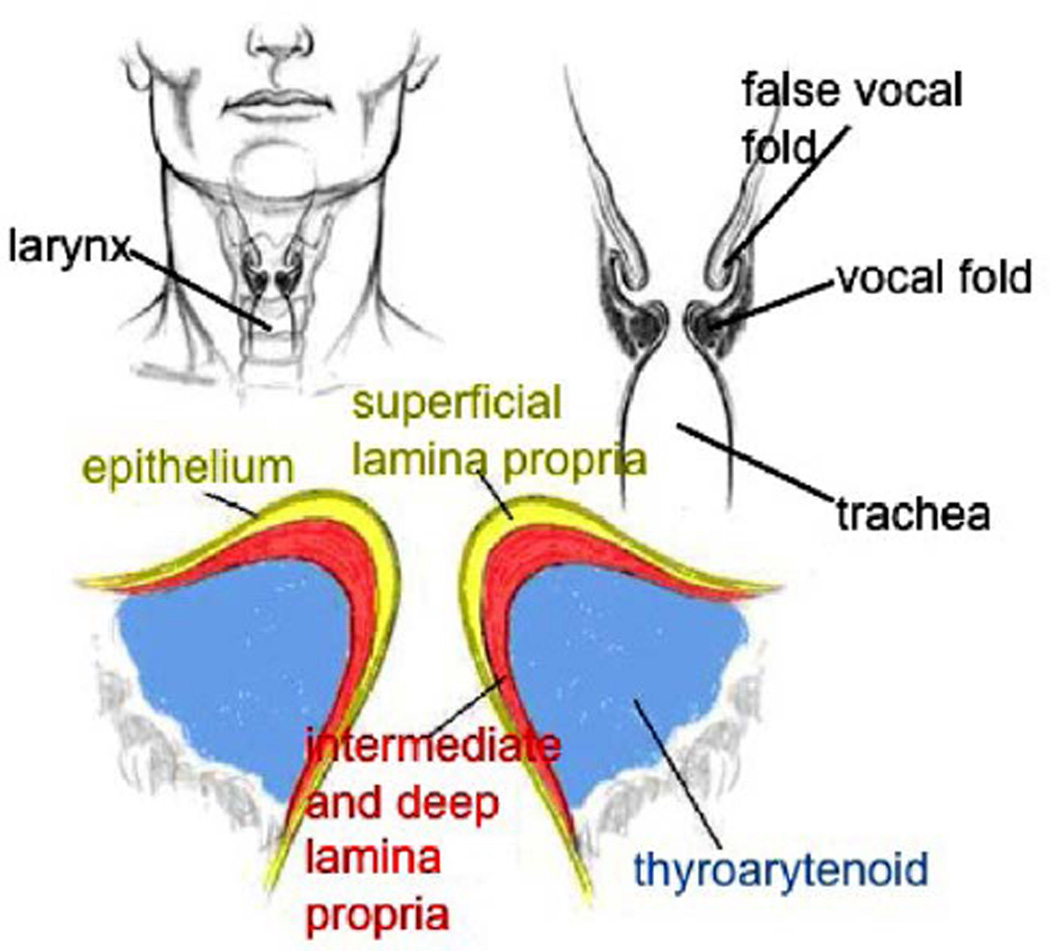
Human vocal folds.